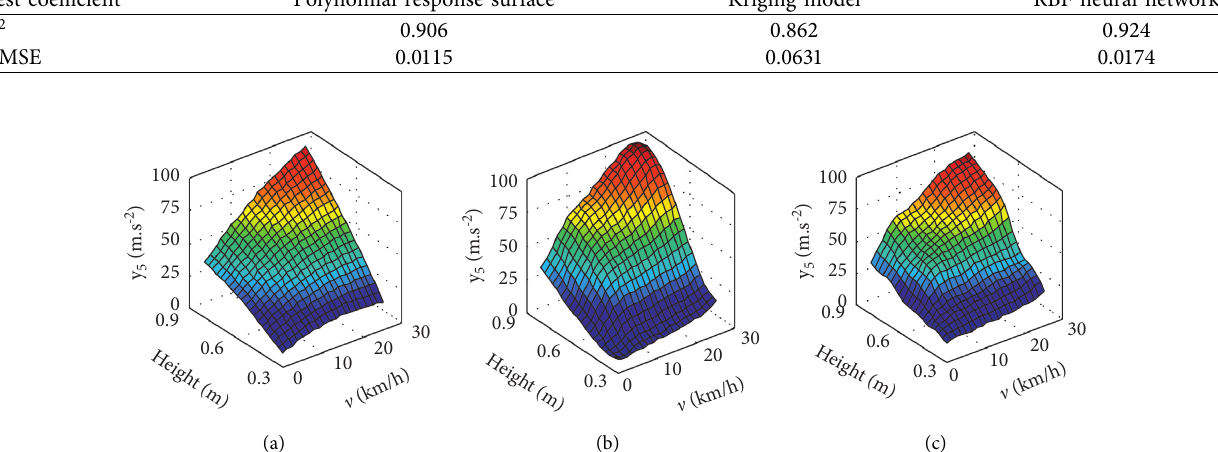
Figure 28: Approximate model of vehicle climbing vertical wall. (a) Polynomial response surface. (b) Kriging model. (c) RBF neural